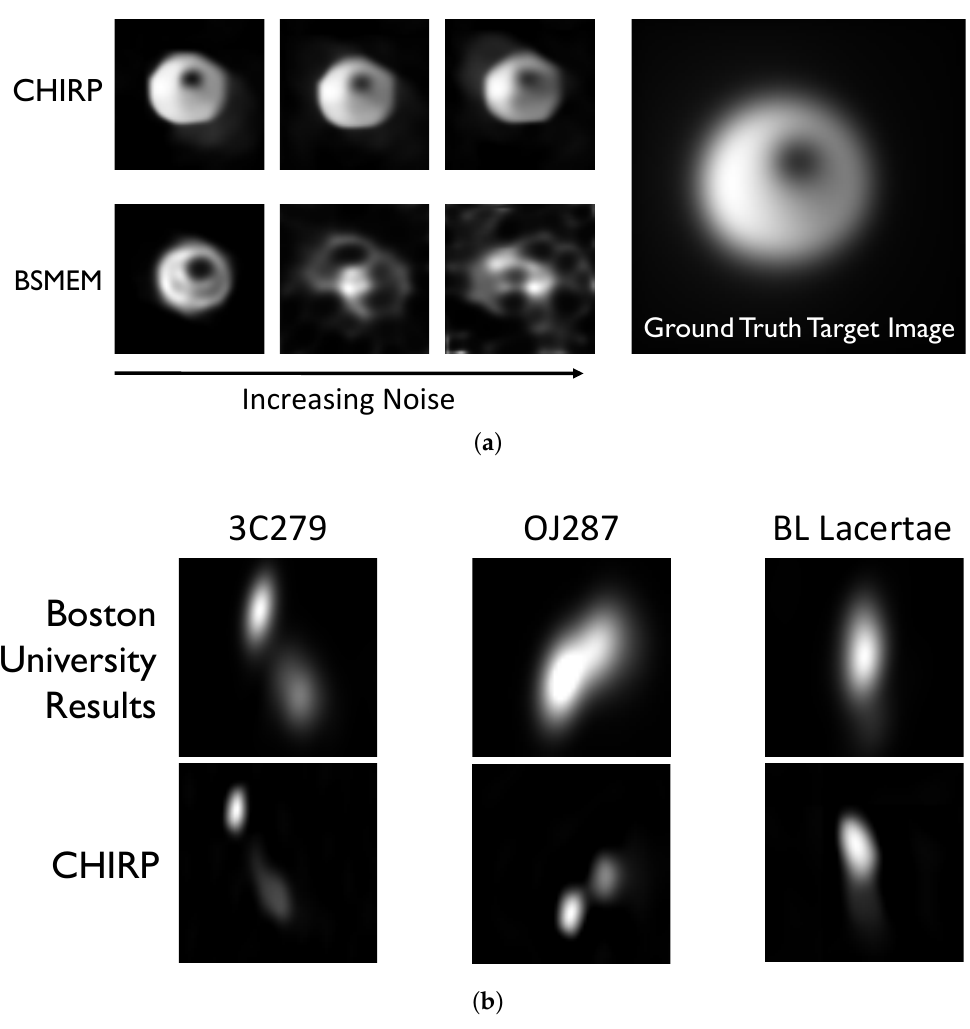
Figure 4. ( a ) Validation of Continuous High-Resolution Image Reconstruction using Patch Priors (CHIRP) on data from the Boston University Blazar Group demonstrating superresolution [49,50]; ( b ) Comparison of CHIRP (trained on natural images) and BiSpectrum Maximum Entropy Method (BSMEM) on reconstructing a black hole model image (courtesy A. Broderick) from simulated data. CHIRP is more robust as the signal-to-noise ratio of the simulated data is lowered. A linear transfer function is used in all